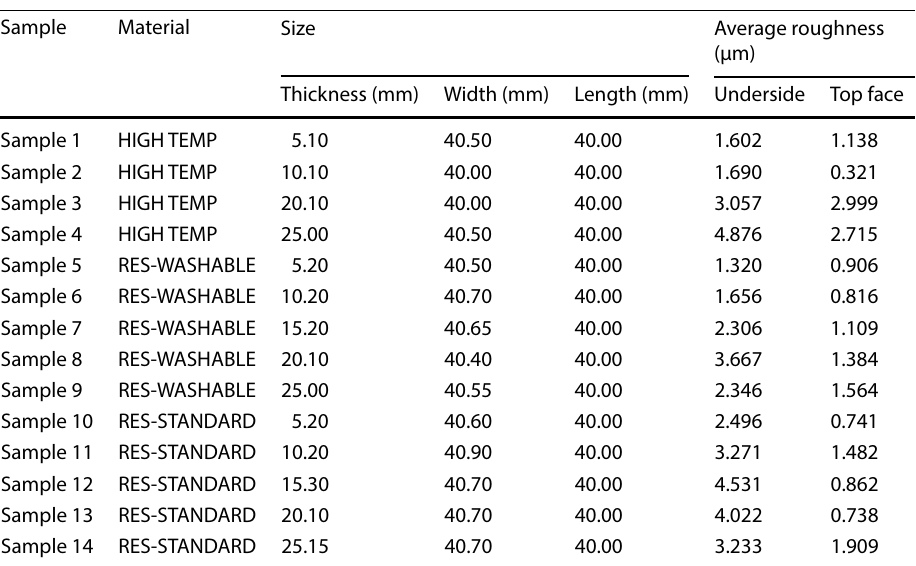
Table 1 Study samples Thermal conductivity study